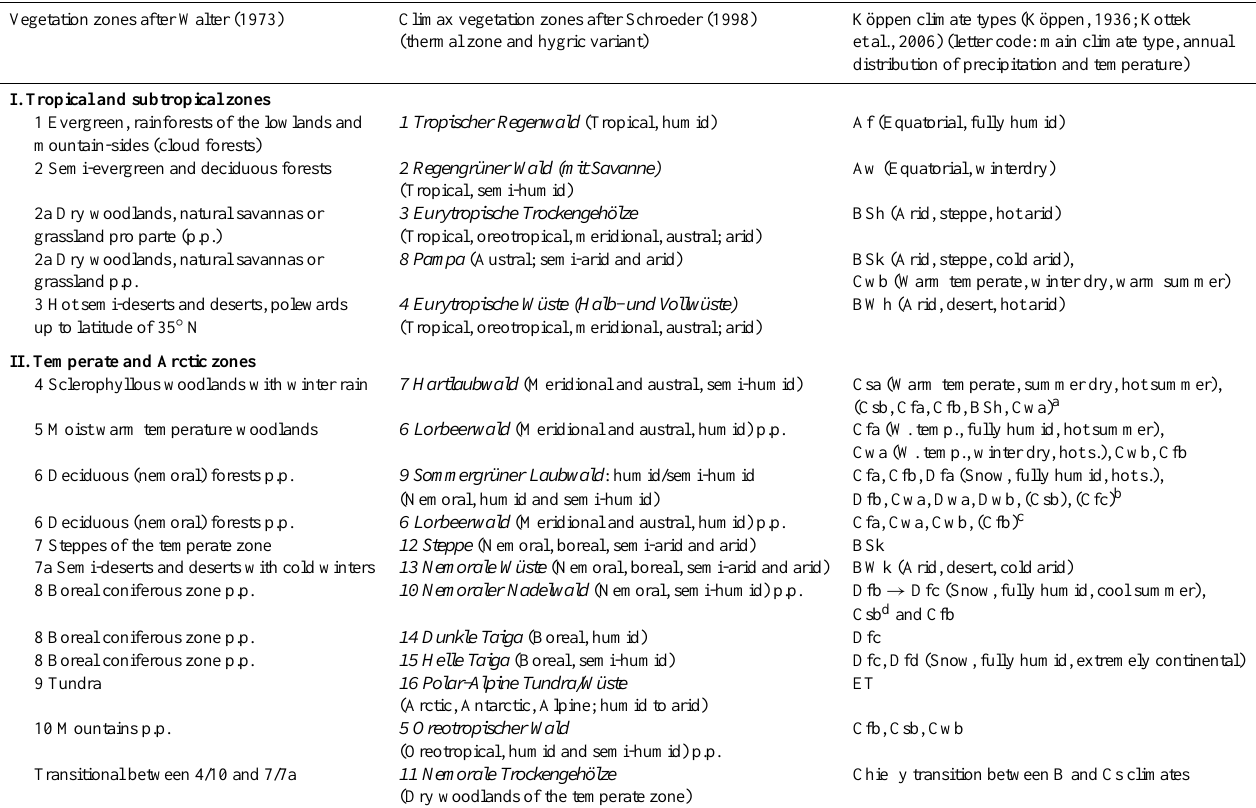
Table 4. Vegetation zones of the Earth and their corresponding Köppen climate types. Vegetation zones after Walter (1973) Climax vegetation zones after Schroeder